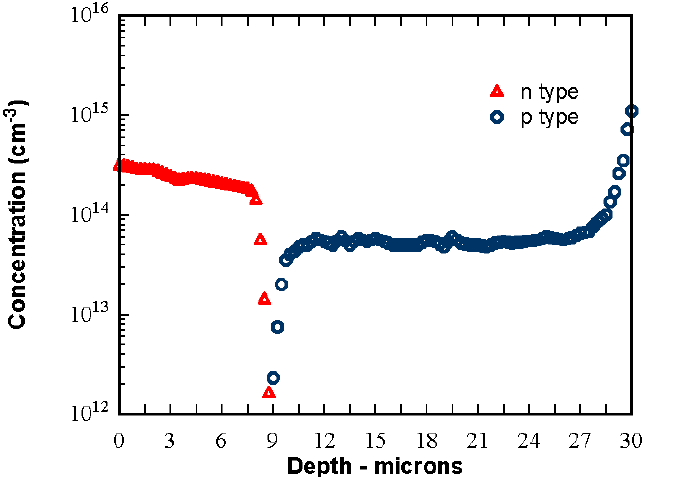
Figure 3. A concentration profile of the gradated double-epi wafer: measurement result by Spreading Resistance (SR)